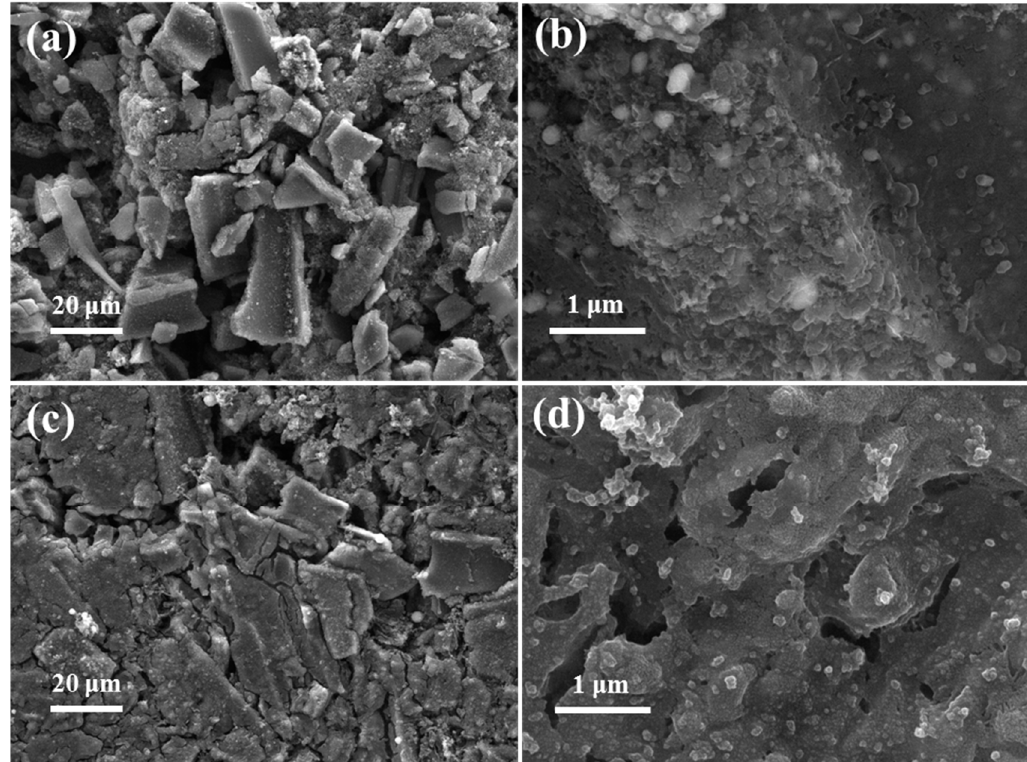
Figure 6. FE-SEM morphologies of ( a , b ) the fresh Fe / Fe 3 C@GC electrode and ( c , d ) the Fe / Fe 3 C@GC after 500 cycles at 500 mA g − 1 .